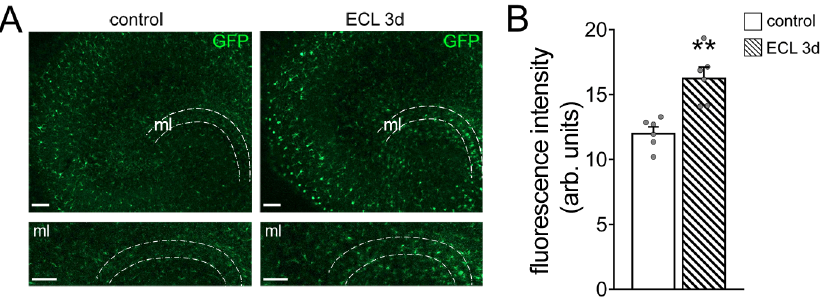
Figure 2. Entorhinal cortex lesion triggers Tnf α gene expression in the molecular layer of the dentate gyrus. ( A ) Representative images of tissue cultures prepared from TNF-reporter mice ( C57BL/6- Tg(TNFa-eGFP) . The molecular layer (ml) is shown at higher magnification. Note increased GFP fluorescence 3 days after entorhinal cortex lesion (ECL). Scale bars 100 µm. ( B ) Group data of GFP fluorescence intensities in the ml of control and denervated tissue cultures (control, n = 6 cultures; ECL 3d, n = 6 cultures; Mann–Whitney test; ** p < 0.01).